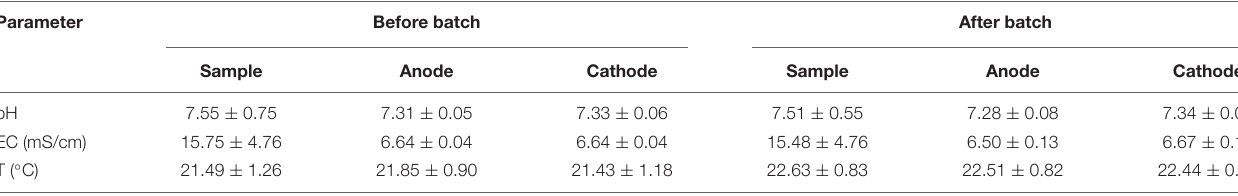
TABLE 2 | Variation of pH and EC during the batch experiments.